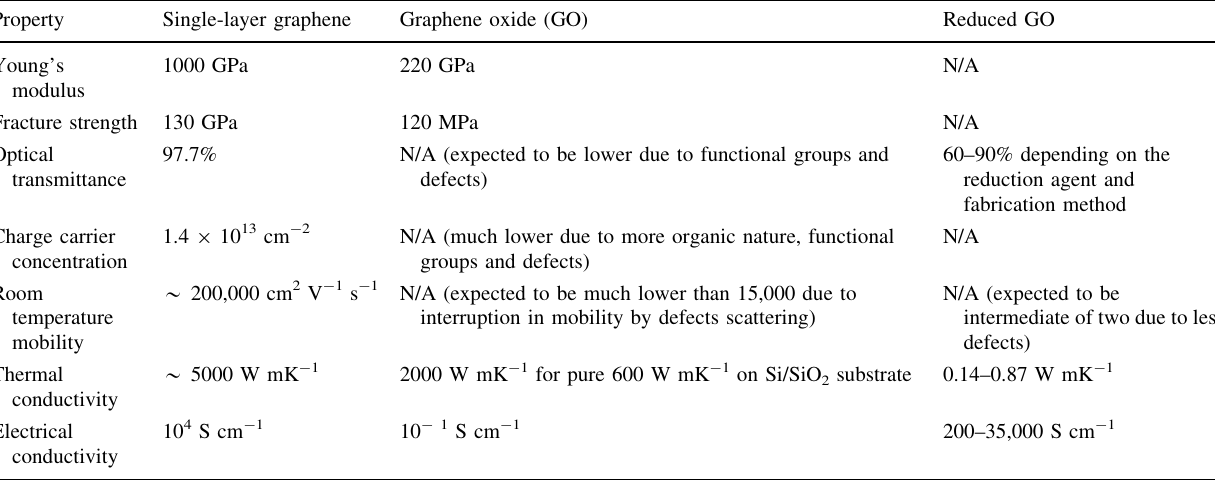
Table 1 Physicochemical properties of GBNs [118]. Copyright (cid:2) Elsevier 2014